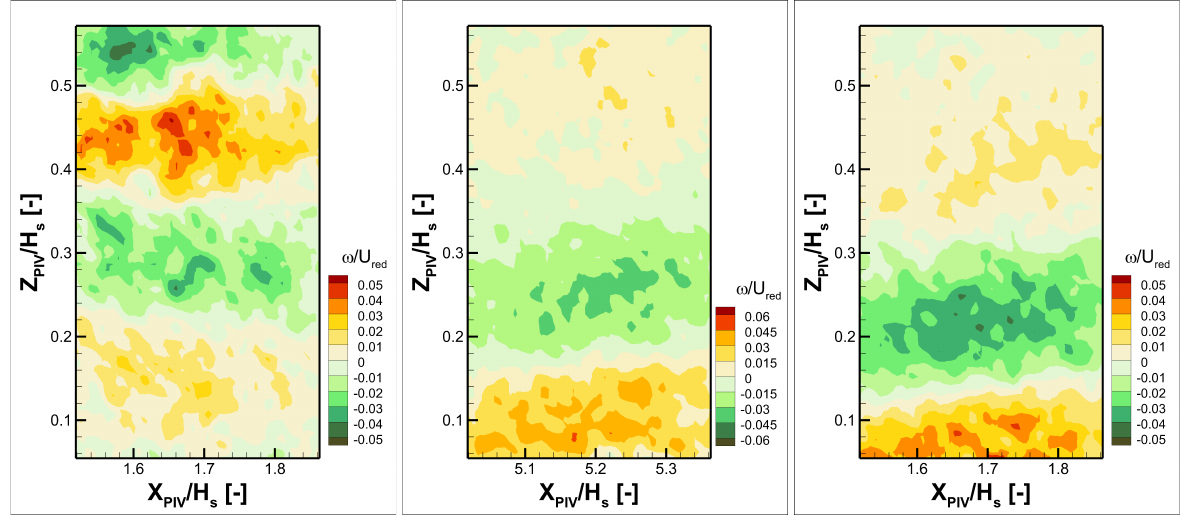
Fig. 6. The relative contribution of the POD modes to the total vorticity for the ABLM1-ABLM5 cases with a reference spire distance D4. The abscissa represents the mode number. Left coordinate represents the relative contribution, right coordinate represents the cumulative contribution.